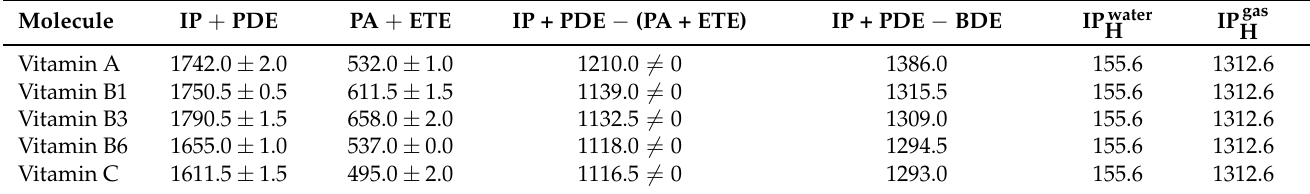
Table 1. The enthalpies of reaction (in kJ/mol) for dietary vitamins in aqueous solution taken from Table 1 of [23] violate Theorem 1; the values in the fourth column should be zero (cf. Equation (4)) but they are not. They also violate Theorem 2; all values of the fifth column should be equal to the H-atom ionization enthalpy in water (sixth column) but they are closer to that in the gas phase (seventh column). All quantities shown here are averages of the values computed using the Minnesota functionals M052x and